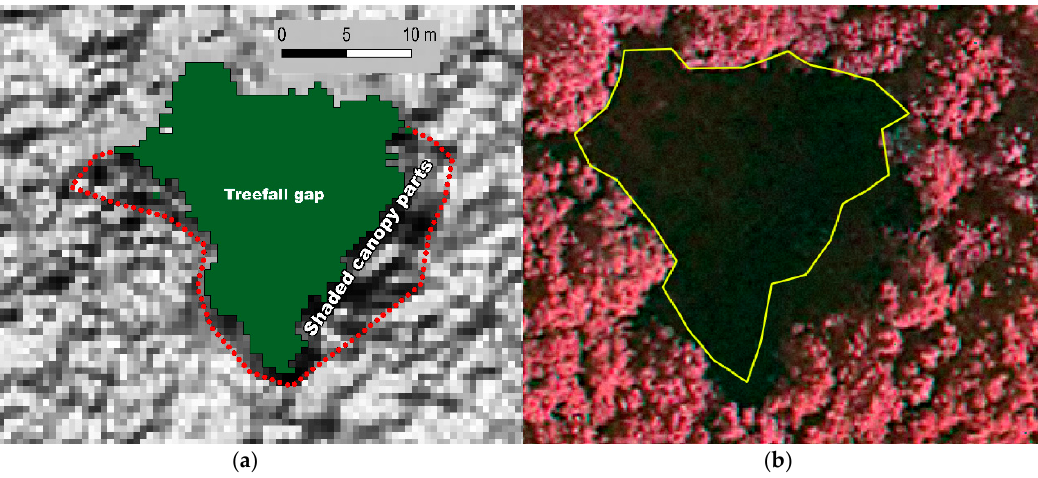
Figure 15. Overestimation of gap size modelled on DSM ( a ) and the same treefall gap contour on a 0.1 m resolution color infrared orthophoto captured with lower sun elevation ( b